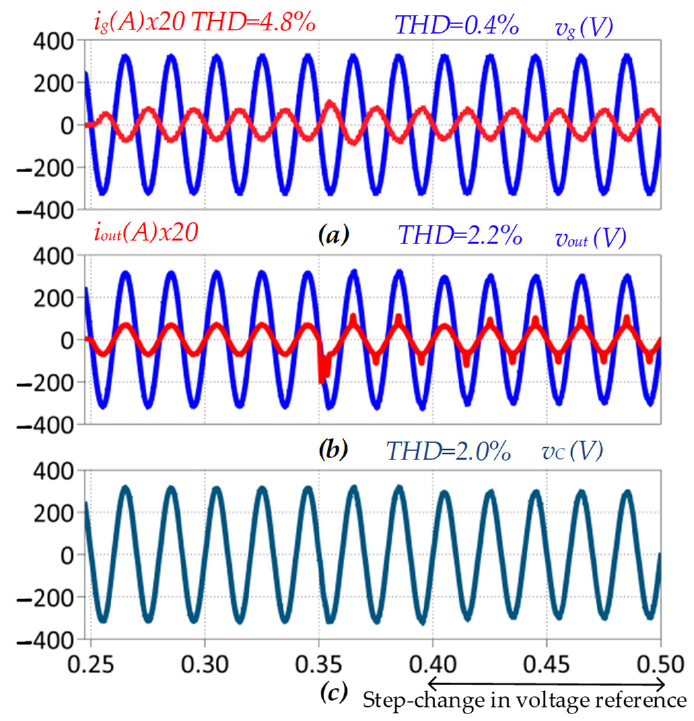
Figure 11. Voltage and current shape at the main grid ( a ), output ( b ), and capacitor of the filter ( c ) in case of drop voltage reference with k out = 0.2, k c = 0.8.